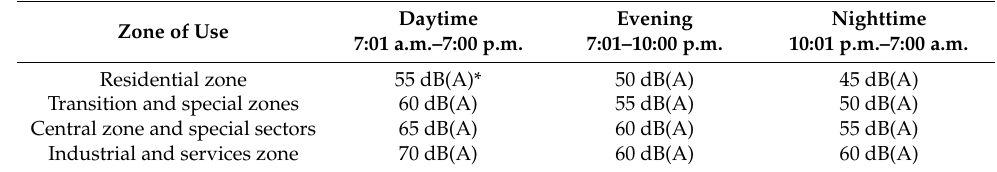
Table 1. Equivalent sound pressure